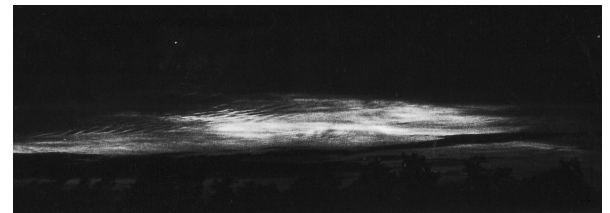
Figure 35. NLC, observed from Juliusruh, 2 July